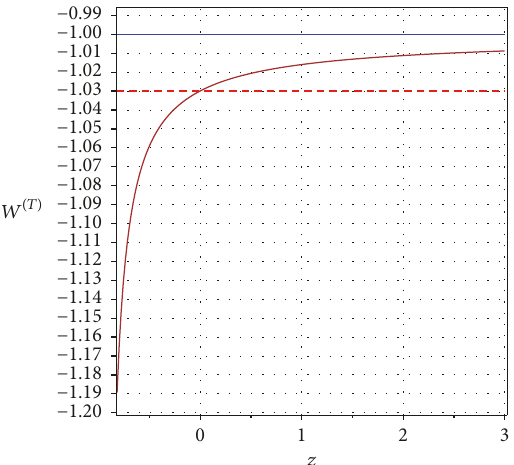
Figure 4: Variation of effective equation of state parameter versus the redshift for 𝑓(𝑇) = 𝑇 + 𝜉𝑇(1 − 𝑒 𝛼𝑇 0 /𝑇 ) , where the dash lines represent 𝜔 (𝑇) 0 = −1.03